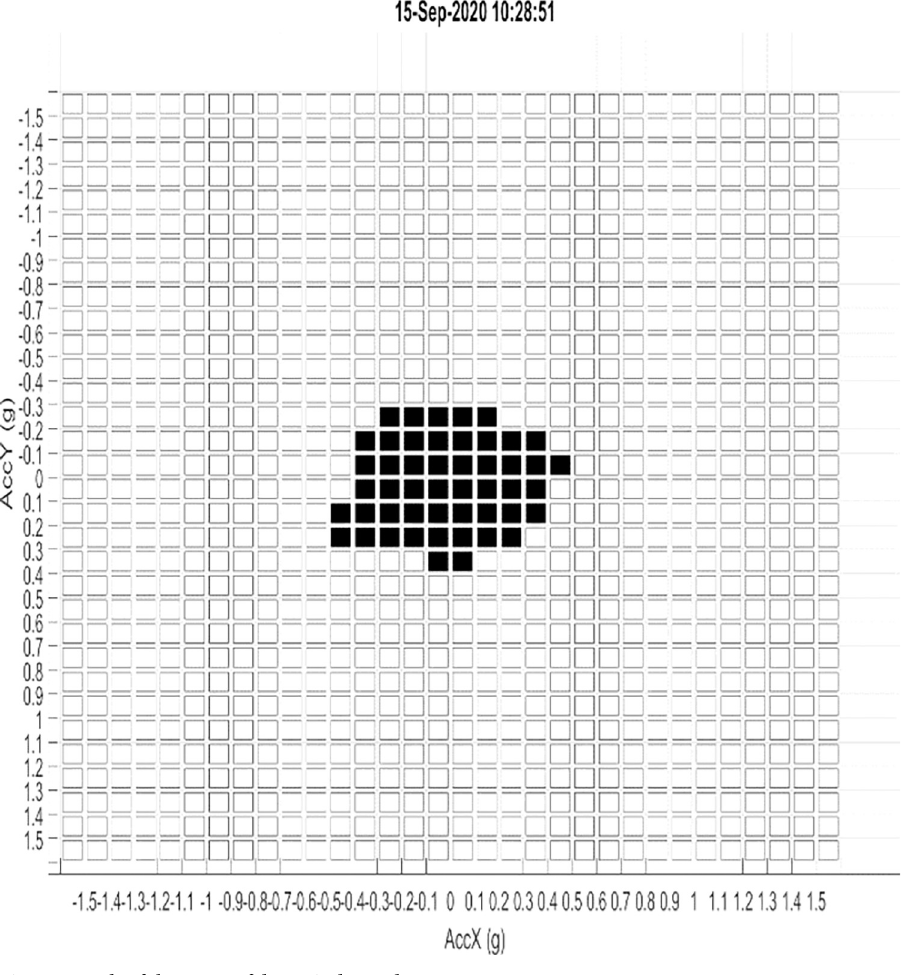
Fig 1. Exemple of the extent of dynamic demands.